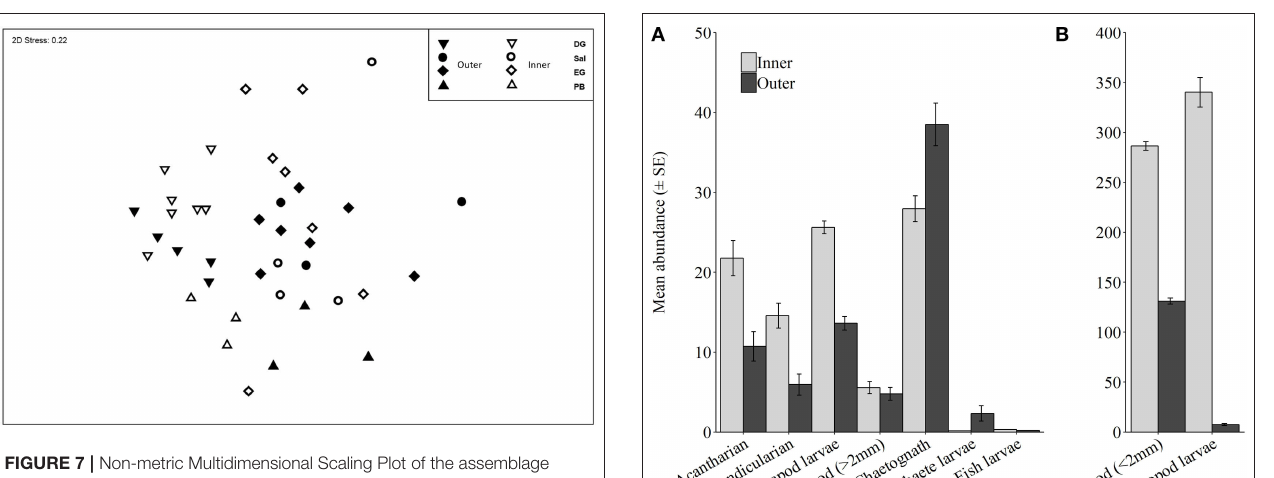
FIGURE 7 | Non-metric Multidimensional Scaling Plot of the assemblage composition of zooplankton, between atolls and regions of Inner and Outer stations.